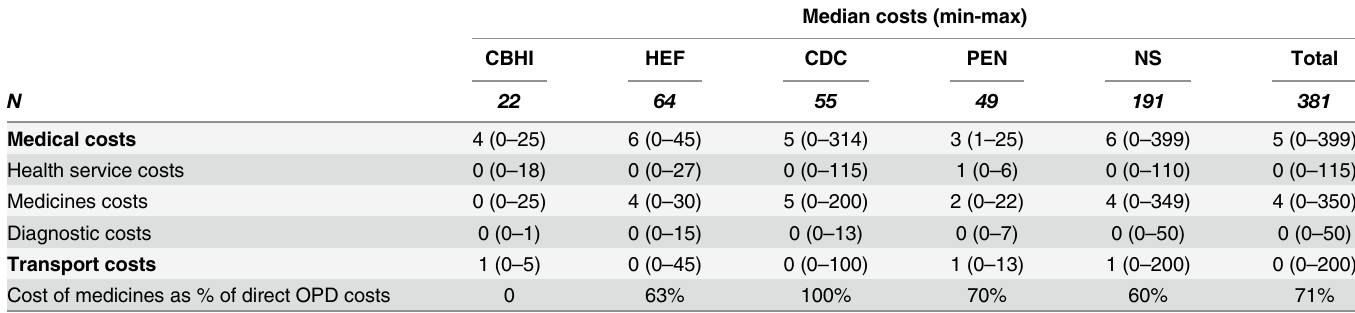
Table 6. Cost of last outpatient consultation in US Dollars § .